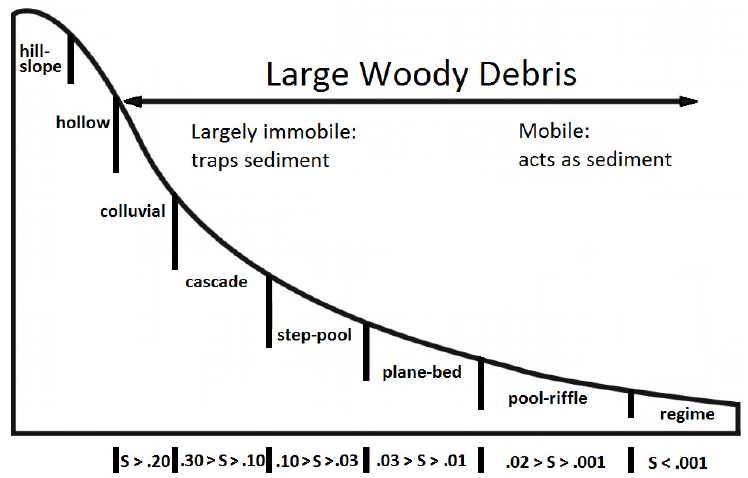
Figure 7. Montgomery and Buffington [35] Stream Classes.